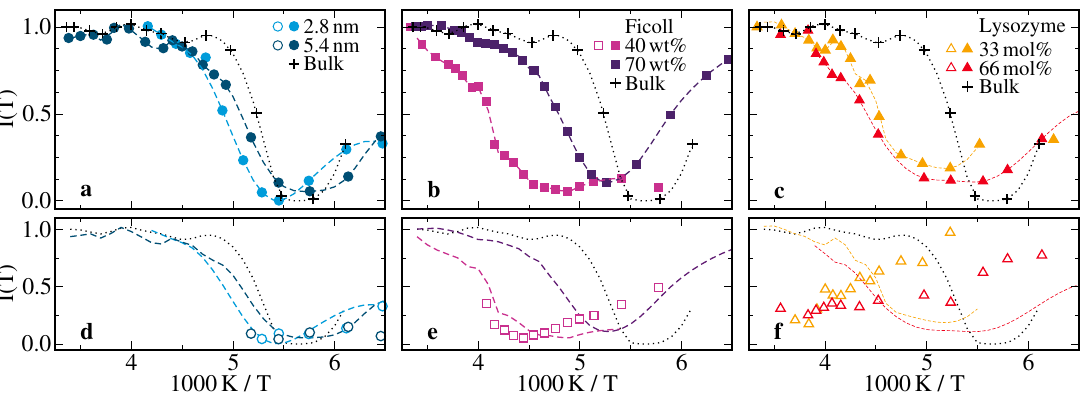
Figure 6. Temperature dependence of the normalized 2 H NMR solid-echo intensities I n ( T ) for 66 mol% D 2 O-DMSO- h 6 solution in ( a , d ) silica pores with diameters of d = 2.8nm and d = 5.4nm, ( b , e ) ficoll at solution mass fractions of w s = 70wt% and w s = 40wt%, and ( c , f ) lysozyme at a solvation level of s = 0.68 g sol / g lys , where results for solutions with 66mol% and 33mol% water are compared. The intensities were obtained from the amplitudes of the 2 H SLR steps and corrected for the Curie factor, explicitly, I n ( T ) = M n ( T ) · T . The upper and lower panels show the results for the faster and slower SLR steps, respectively. The corresponding data for the 66 mol% D 2 O-DMSO- h 6 bulk solution are included for comparison. Identical lines are shown in the upper and lower panes as guides for the